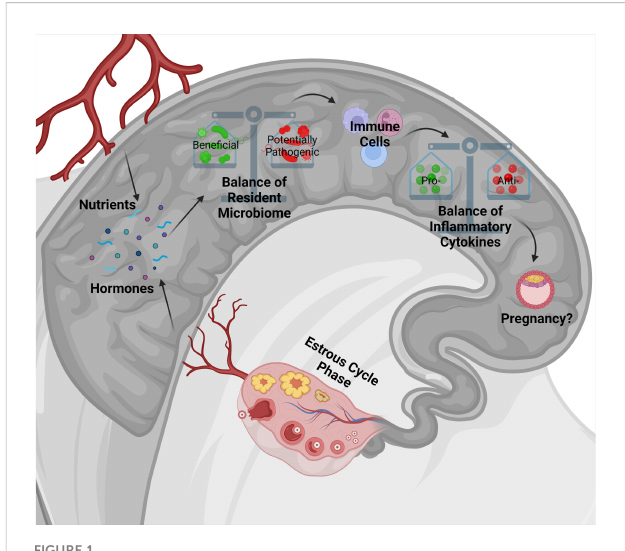
FIGURE 1 The proposed model indicates the interaction of nutrition and phases of the estrous cycle with uterine bacterial communities and immune response, potentially impacting pregnancy establishment. Nutrients and hormones, depending on the stage of the estrous cycle, can alter the uterine environment and affect the balance of the uterine bacterial communities positively or negatively. Depending on the uterine bacterial community composition, bacteria can release their products into the uterine environment or bind to receptors on uterine endometrium to affect immune cell development. Immune cells may then be activated toward a pro- or anti- in fl ammatory state which will in fl uence the cytokines produced and released in the uterine environment. Together, these factors have a strong in fl uence on pregnancy establishment or